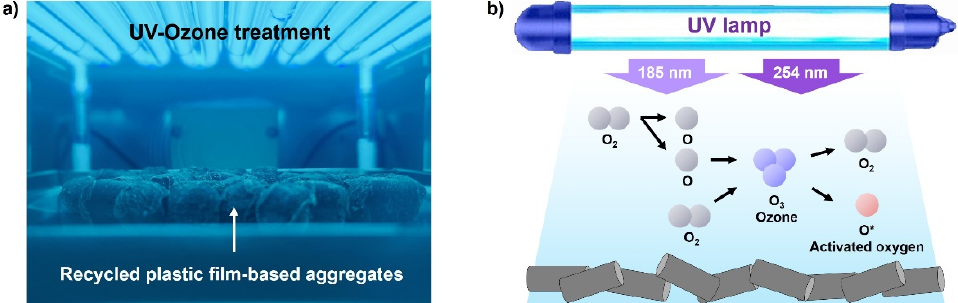
Figure 2. ( a ) Photograph and ( b ) schematic of the current work showing UV-O 3 treatment of recy- cled plastic film-based aggregates. The 254 nm of UV light decomposes ozone (purple color) and produces activated oxygen (red color) with high energy.